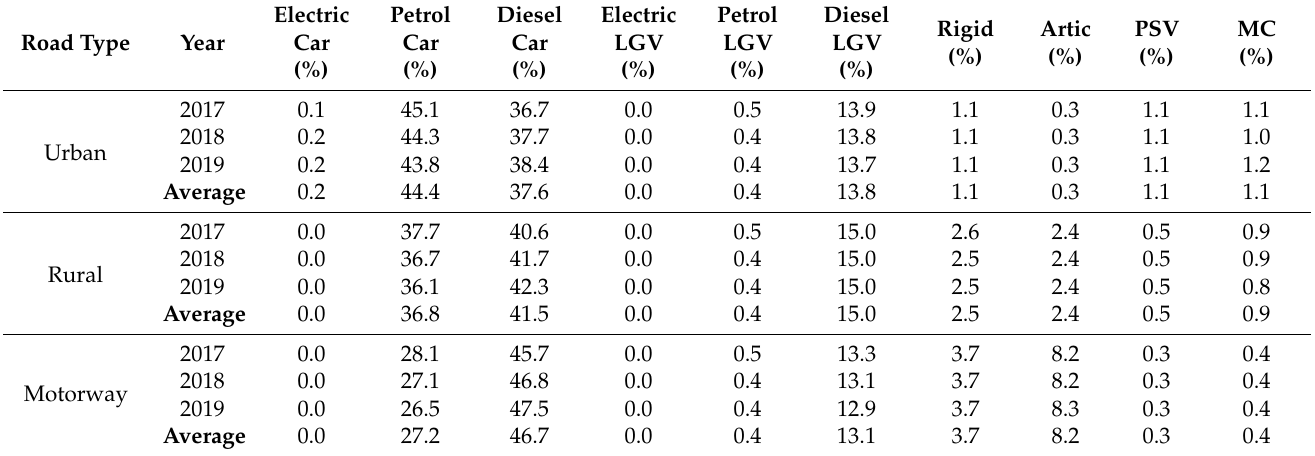
Table 2. Fleet distribution according to the fuel type. These data were extracted from the National Atmospheric Emission Inventory [43]. MC and PSV are corresponded with motorcycles and public service vehicle, respecively.